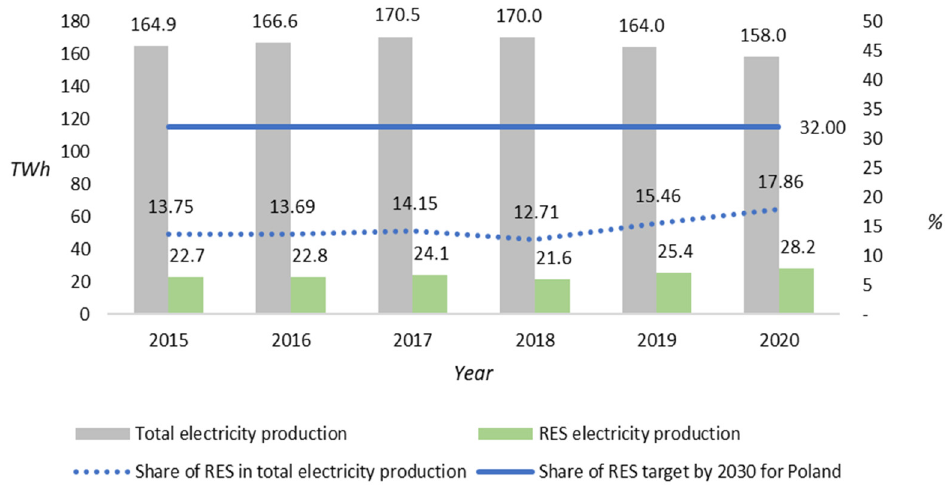
Figure 2. The share of renewable energy sources in the total production of electricity in Poland by sources in 2015–2020. Source: own elaboration based on